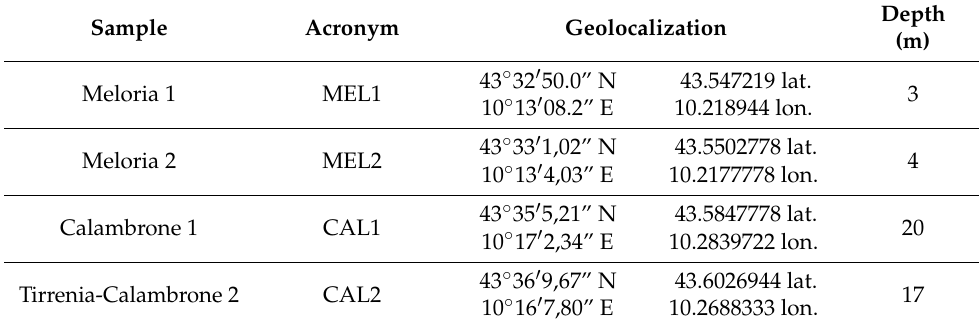
Table 1. Sample acronyms and relevant sampling sites coordinates and